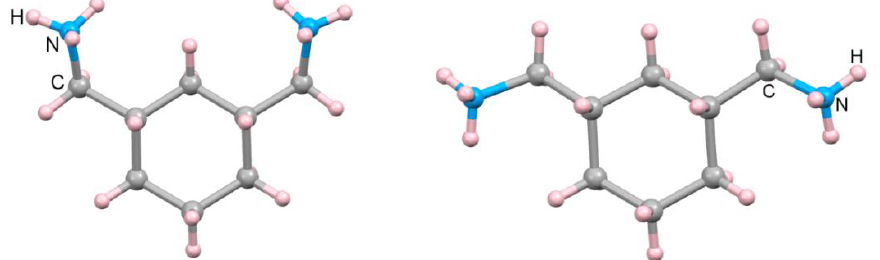
Figure 3. The two methylammonium groups exist in the cis configuration with upward orientation ( left ) and downward orientation ( right ).